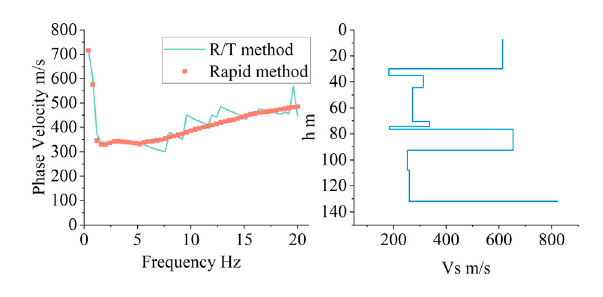
FIGURE 11 Interpolated phase velocity dispersion curve graph and its velocity structure